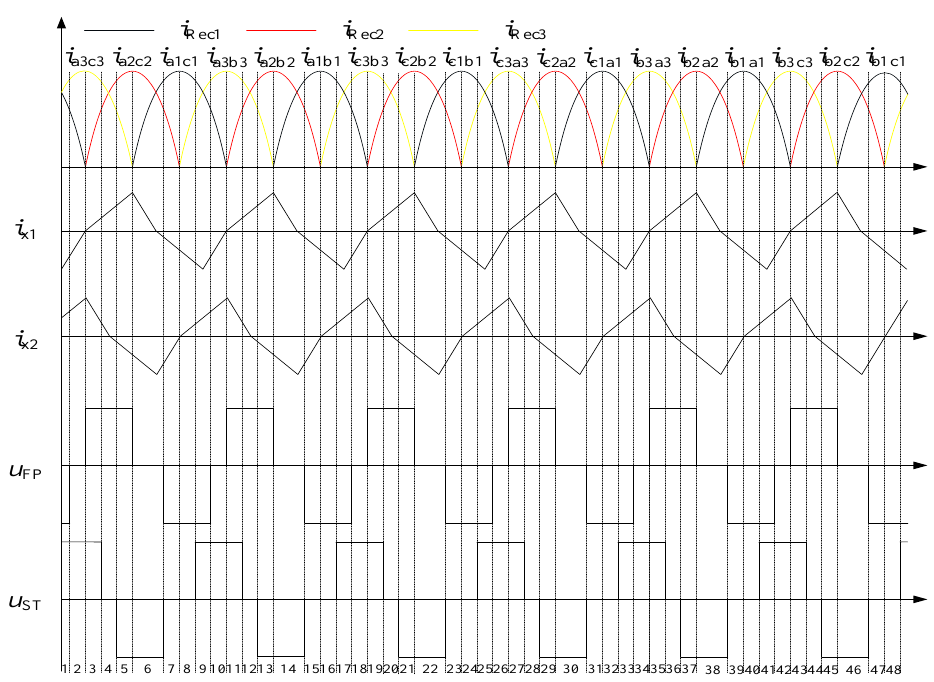
Figure 7. Operating waveforms of the proposed rectifier.